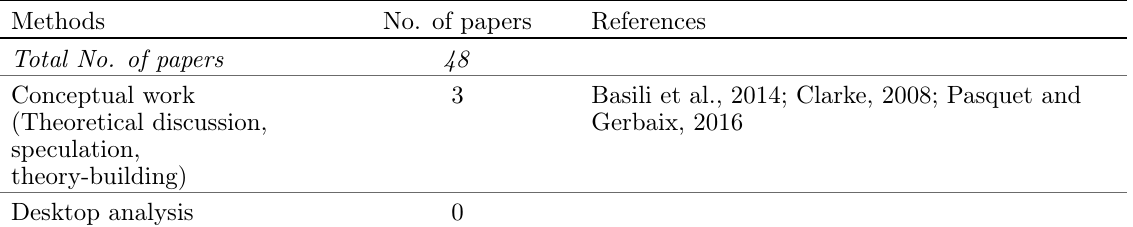
Table B.2 . Research methods used in studies on mobile payments technology aspects.